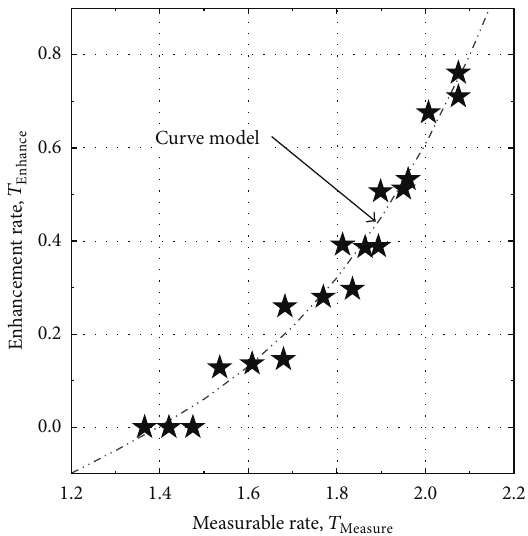
Figure 10: Relation and a unified curve model to obtain the according to the measurable rate 𝑇 enhancement rate 𝑇 Enhance by considering the low, medium, and high dielectric properties of